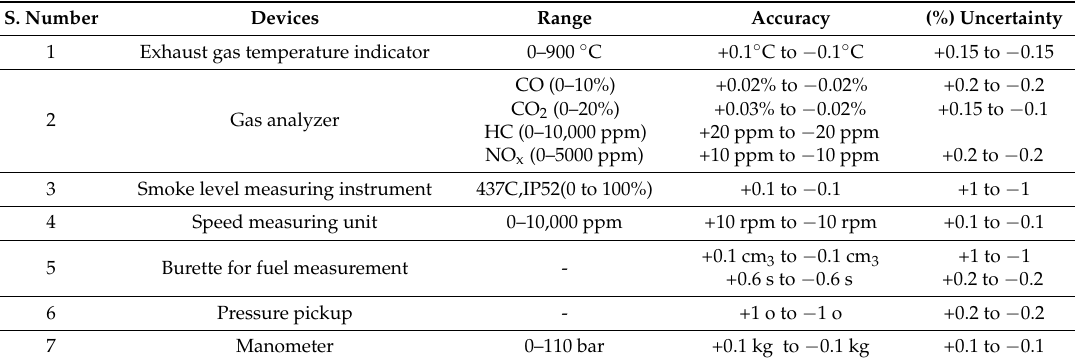
Table 7. List of devices, its range, accuracy, and